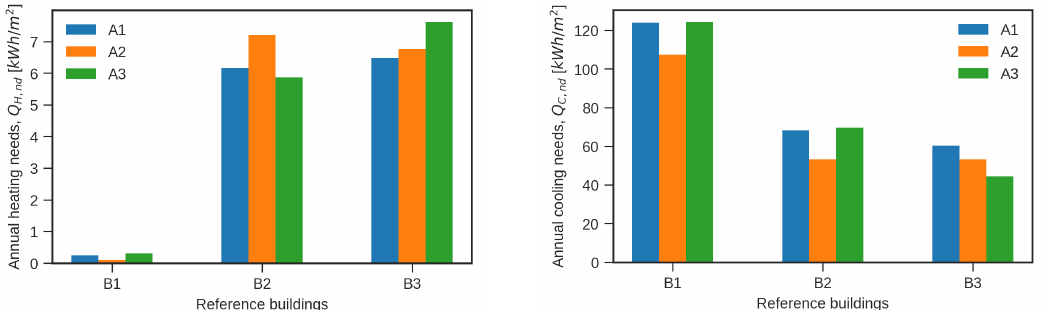
Figure 14. Comparison of the results described in Section 4.2.1— A1 with the results for